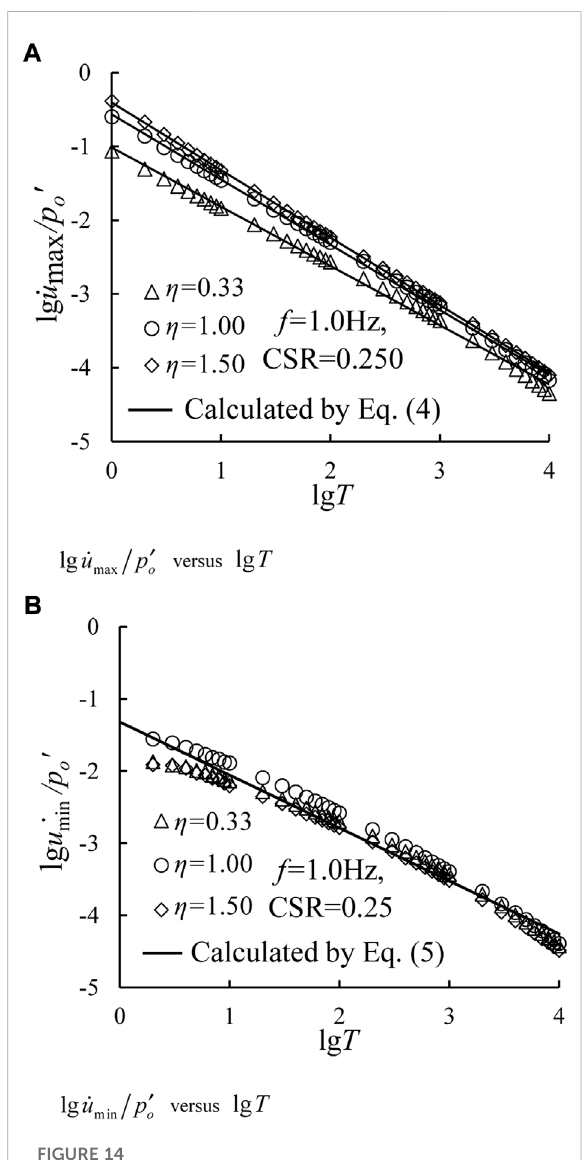
FIGURE 14 Relationships between lg _ u max / p ′ o and lg _ u min / p ′ o versus lg T underdifferent η valuesfor f =1.0 HzandCSR=0.25. (A) lg _ u max / p ′ o versus lg T and (B) lg _ u min / p ′ o versus lg T